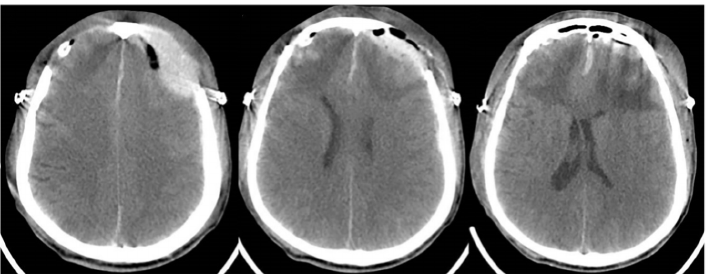
Figure 3. The craniocerebral CT examination on the first postoperative day. The bilateral frontal bones showed postoperative changes, with gas accumulation in the operative area, reduced hematoma range, and little change in the surrounding low-density edema zone.